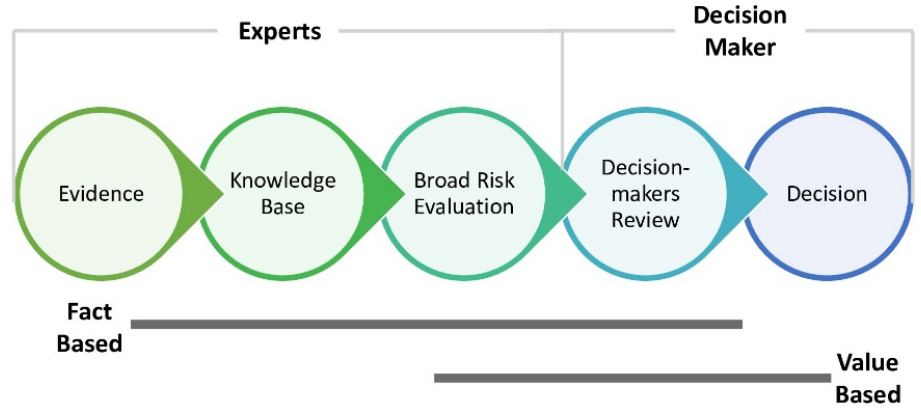
Figure 1. The links between facts and values in risk decision-making [9].